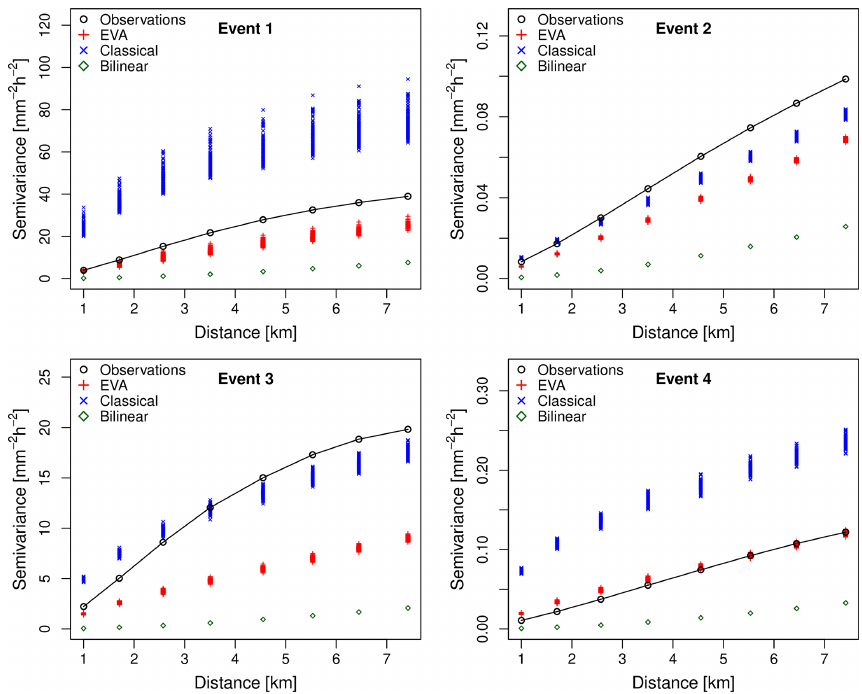
Figure 13. Sample variograms of rainfall intensity (given occurrence) for events 1–4 and spatial displacements up to 8km. The downscaling factor is 64 (i.e., input resolution of 8km × 8km and target resolution of 1km × 1km). For each cascade model, 100 different realizations were generated. The generator model was estimated from the coarse-scale data at an 8km × 8km